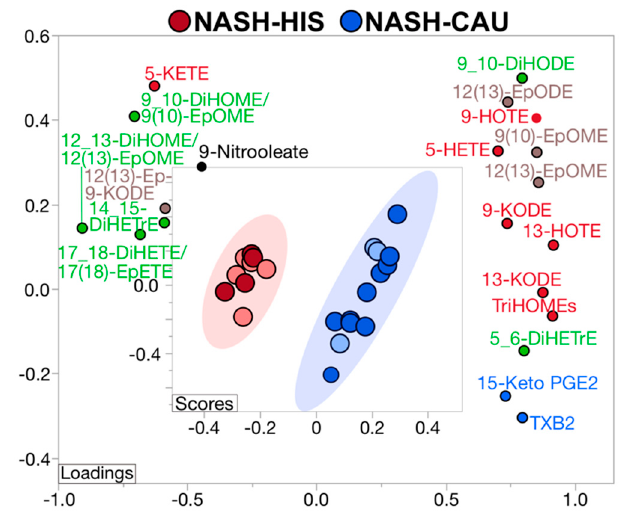
Figure 3. Supervised multivariate clustering model demonstrating ethnicity specific oxylipins pro- file discriminates Hispanic (HIS) and Caucasian (CAU) with non-alcoholic steatohepatitis (NASH) without advanced fibrosis. Score plot for NASH-HIS (red) vs. NASH-CAU (blue) when excluding stage 3 and 4 fibrosis. Light color represents subjects from primary cohort and dark color represents secondary cohort. The model was performed on all profiled lipids. Lipid mediators are colored according to metabolizing enzyme pathways, lipoxygenase, and autoxidation (red); cytochrome p450 epoxygenase (brown); and soluble epoxide hydrolase (green); cyclooxygenase (blue); other (black). The model was validated with leave-one-out cross validation. The Q 2 and R 2 are 0.99 and 0.98, respectively. Details on variable importance into the projection scores are shown in Table S4. NASH